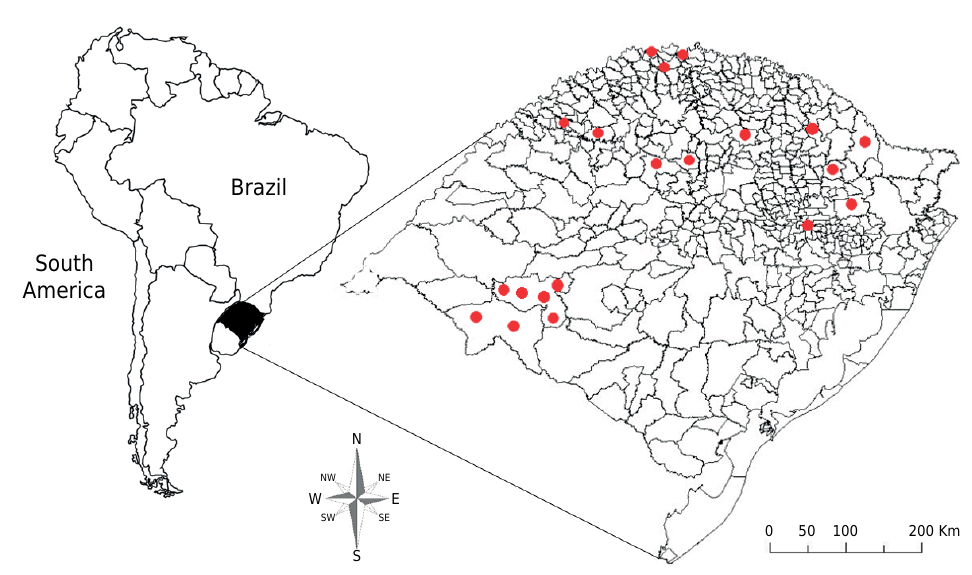
Figure 1. The State of Rio Grande do Sul, Brazil. Red circles represent the sites where the soil samples used in this study were